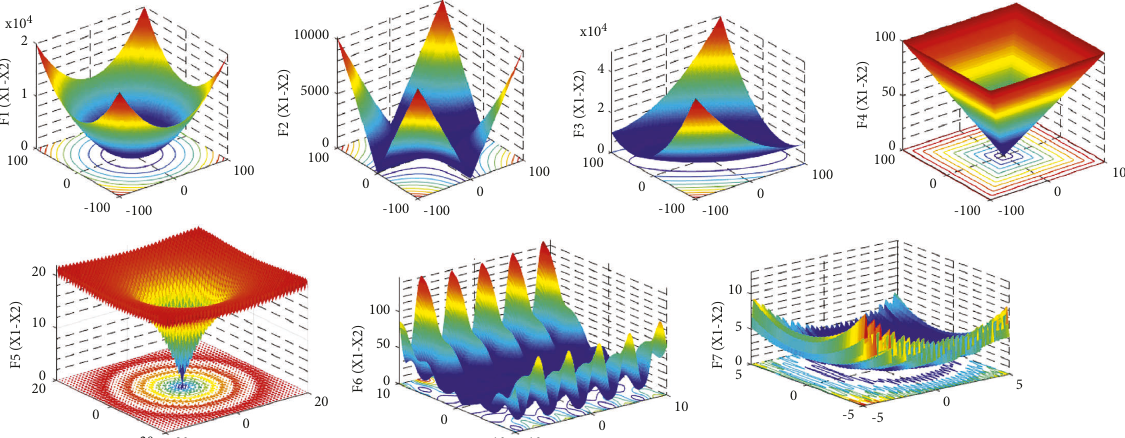
Figure 7: Representation of